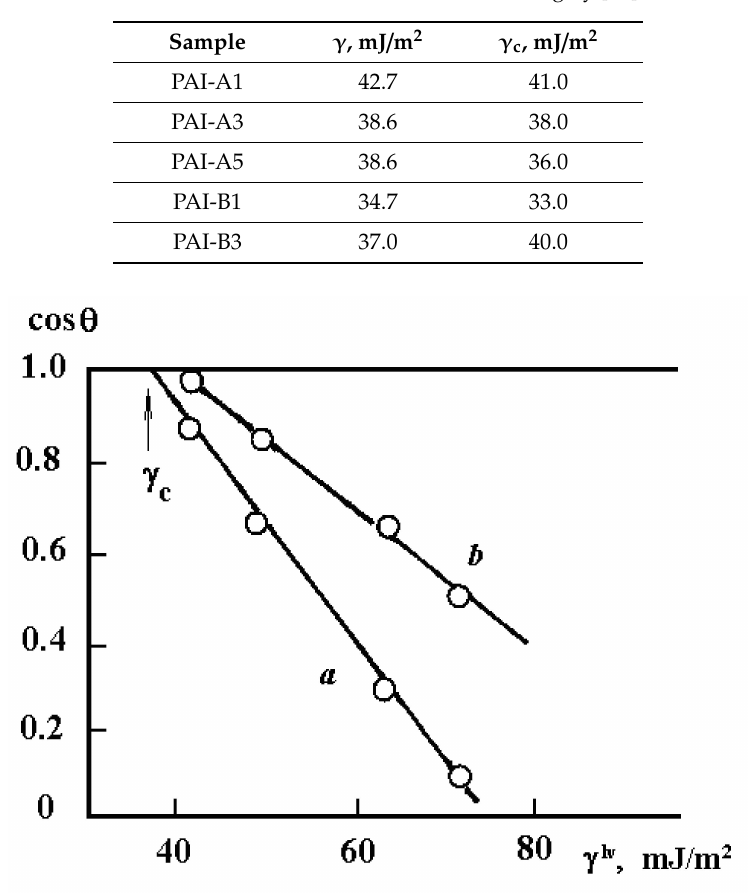
Figure 3. Dependence of cos θ on surface tension of liquids. ( a ) PAI-A and ( b )